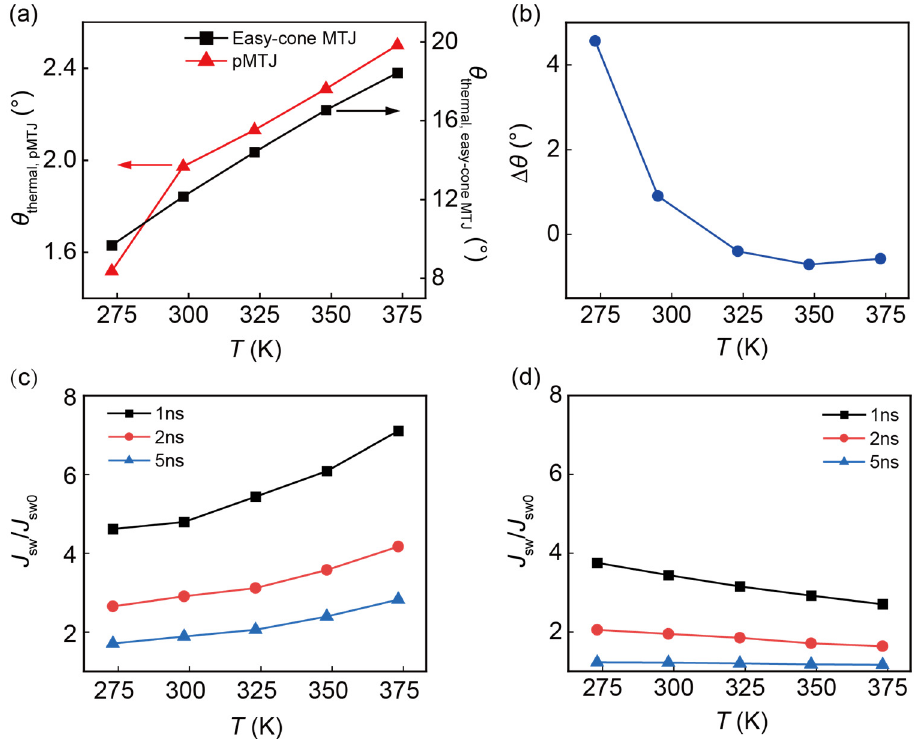
Figure 4. ( a ) θ thermal as a function of temperature for the easy ‐ cone MTJ and pMTJ. ( b ) The difference between θ c and θ thermal is represented as ∆ θ . The current overdrive as a function of temperature in ( c ) pMTJ and ( d ) easy ‐ cone MTJ.